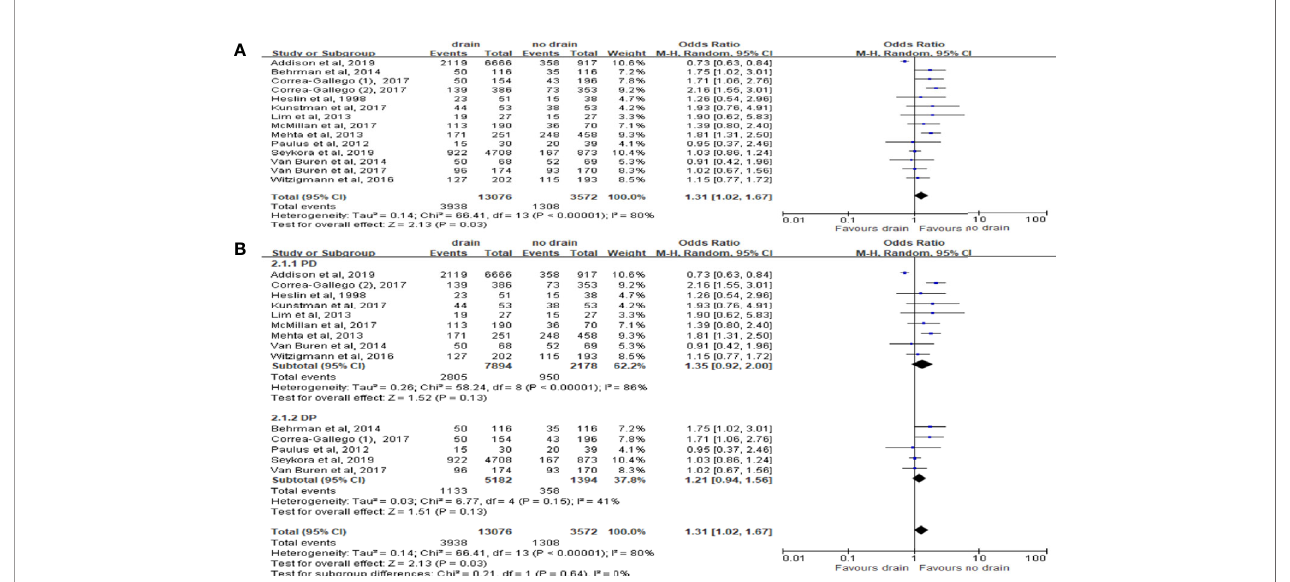
FIGURE 4 | Forest plot of the comparison of morbidity in drain versus no-drain groups after pancreatic resection. (A) Comparison in overall; (B) comparisons in PD and DP subgroups, respectively.